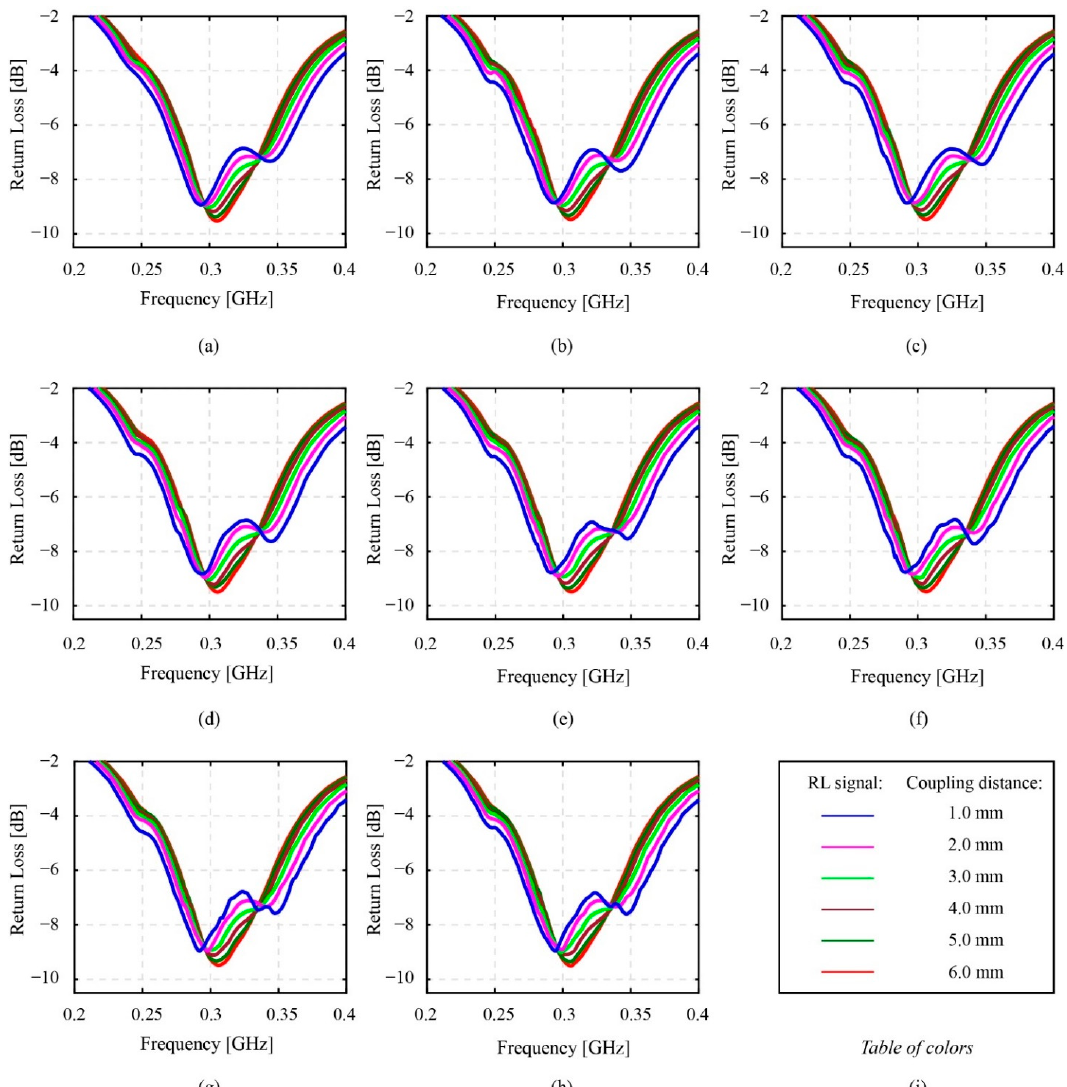
Figure 16. The effect of phase fluctuation at various speed from Stop - 0 rpm to 3500 rpm with coupling distance from 1 mm to 6 mm (limited to the vicinity of 0.3 GHz valley): ( a ) Stop − 0 rpm, 1 − 6 mm; ( b ) 500 rpm, 1 − 6 mm; ( c ) 1000 rpm, 1 − 6 mm; ( d ) 1500 rpm, 1 − 6 mm; ( e ) 2000 rpm, 1 − 6 mm; ( f ) 2500 rpm, 1 − 6 mm; ( g ) 3000 rpm, 1 − 6 mm; ( h ) 3500 rpm, 1 − 6 mm; ( i ) description of chart